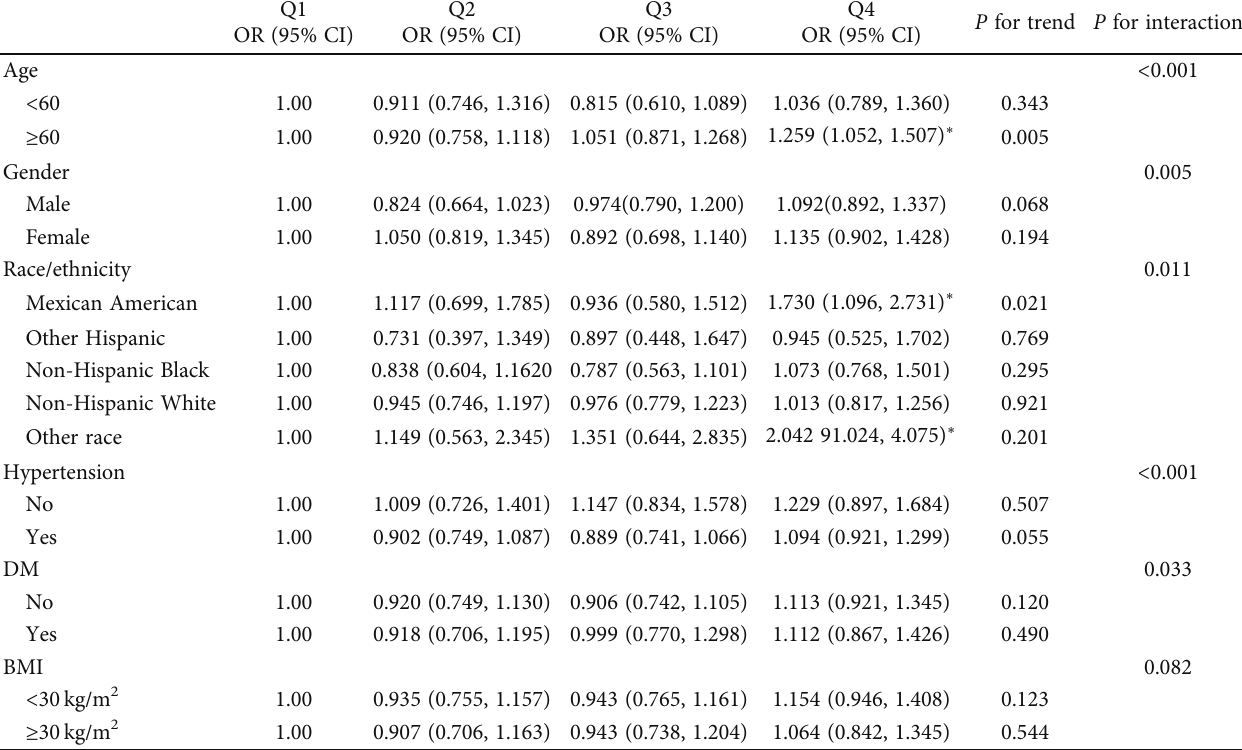
Table 4: Subgroup analysis for the associations of SII index with the prevalence of total CVD.